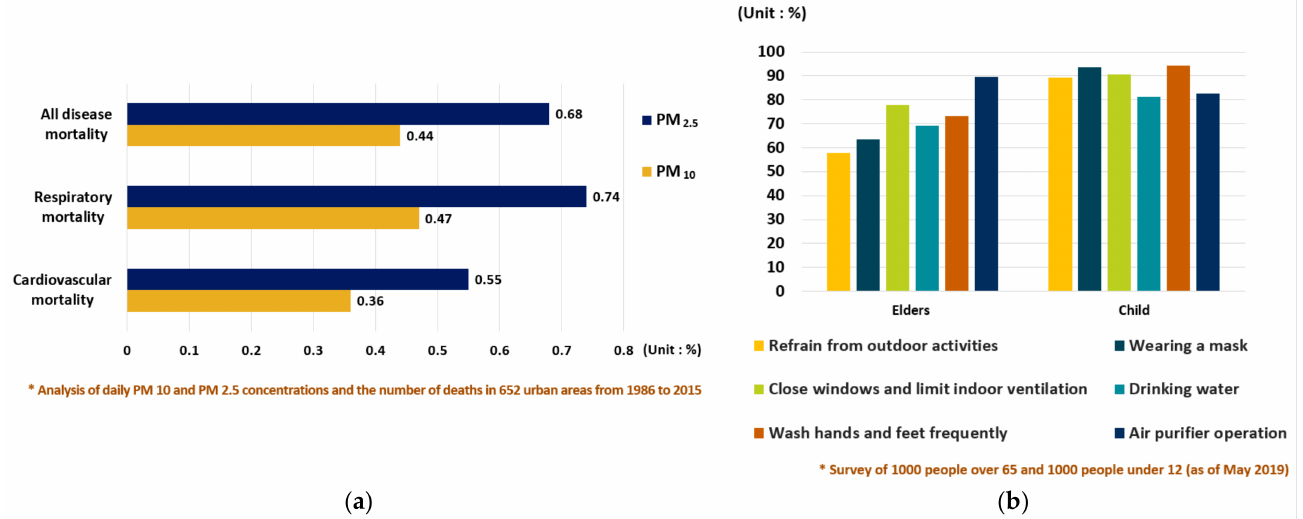
Figure 2. ( a ) Increases in death rate by disease according to the rising PM 10 and PM 2.5 concentra- tions [10]. ( b ) Application rate for each method of coping with PM in the elderly and children